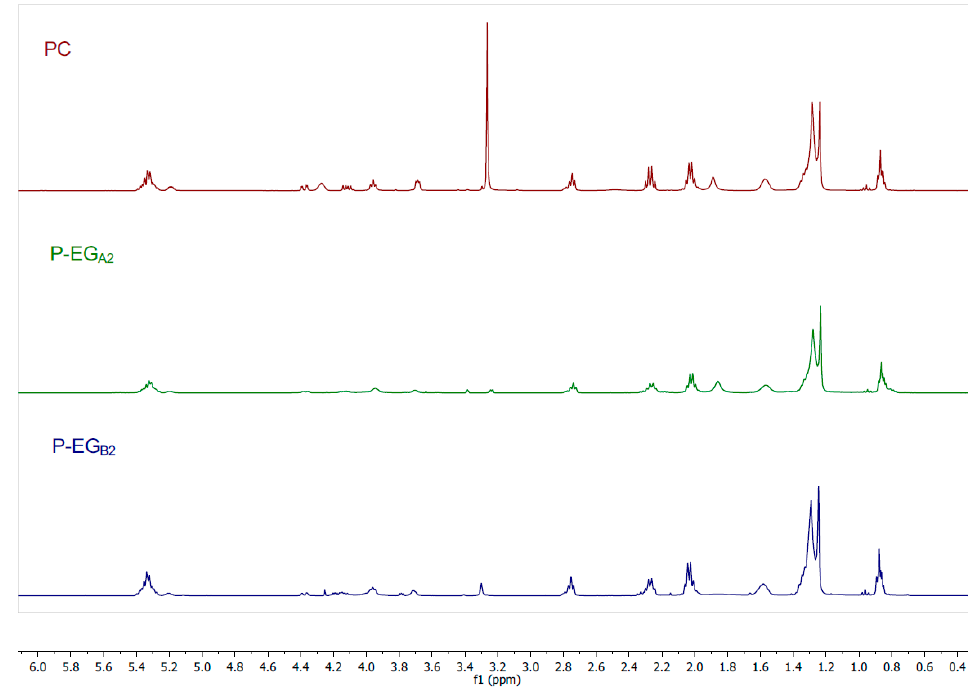
Figure 7. 1 H NMR spectra of starting PC (red line), P-EG A2 (green line) and P-EG B2 (blue line) in D 2 O.